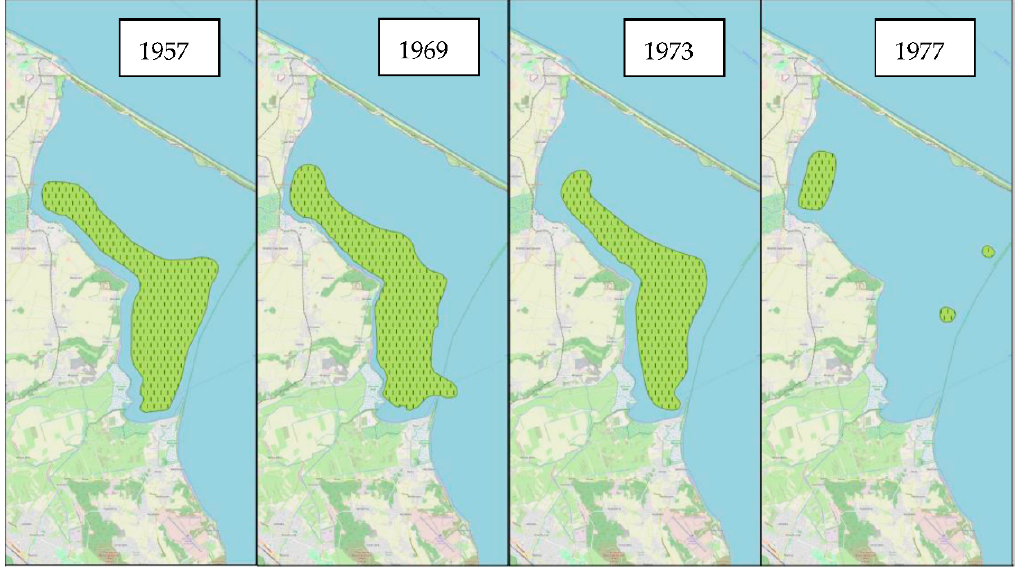
Figure 5. Changes in the distribution of Furcellaria lumbricalis and Coccotylus brodiei in Puck Bay between 1957 and 1988 (based on data available in [1,3,4,25])